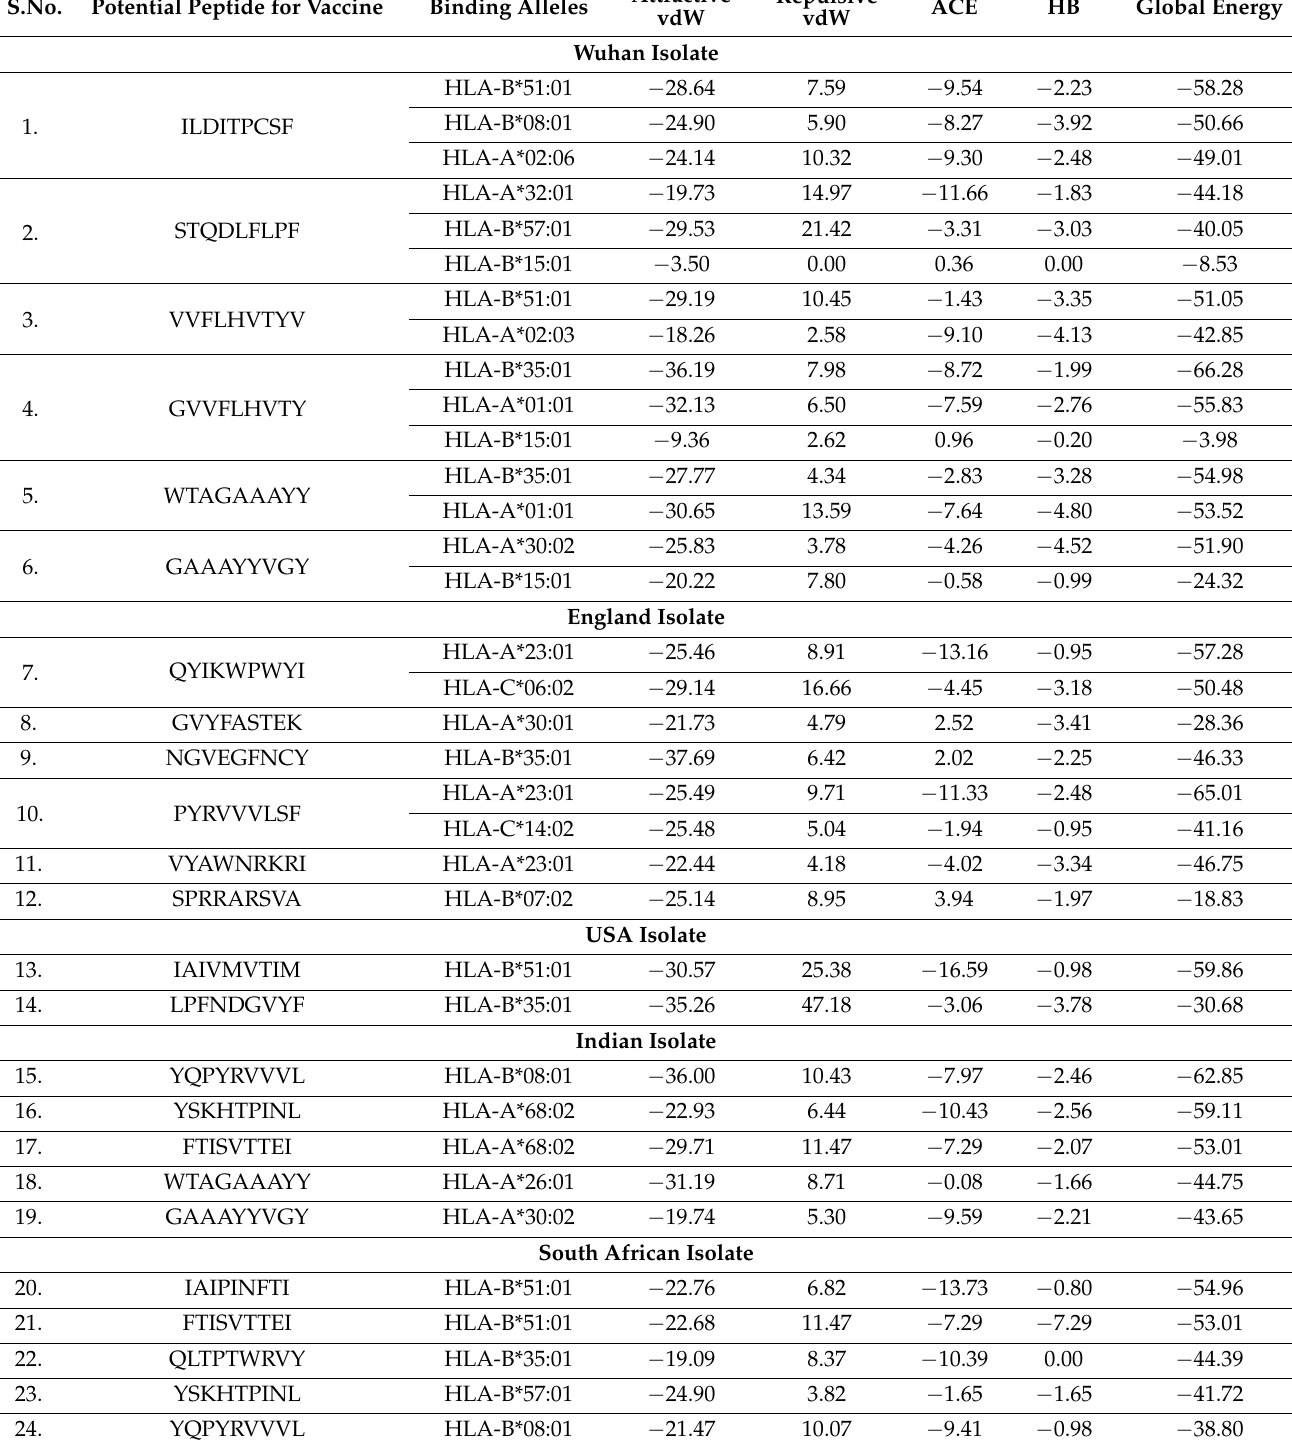
Table 7. Binding interactions of the best T-cell epitopes of the SARS-CoV-2 variants with their MHC I alleles.